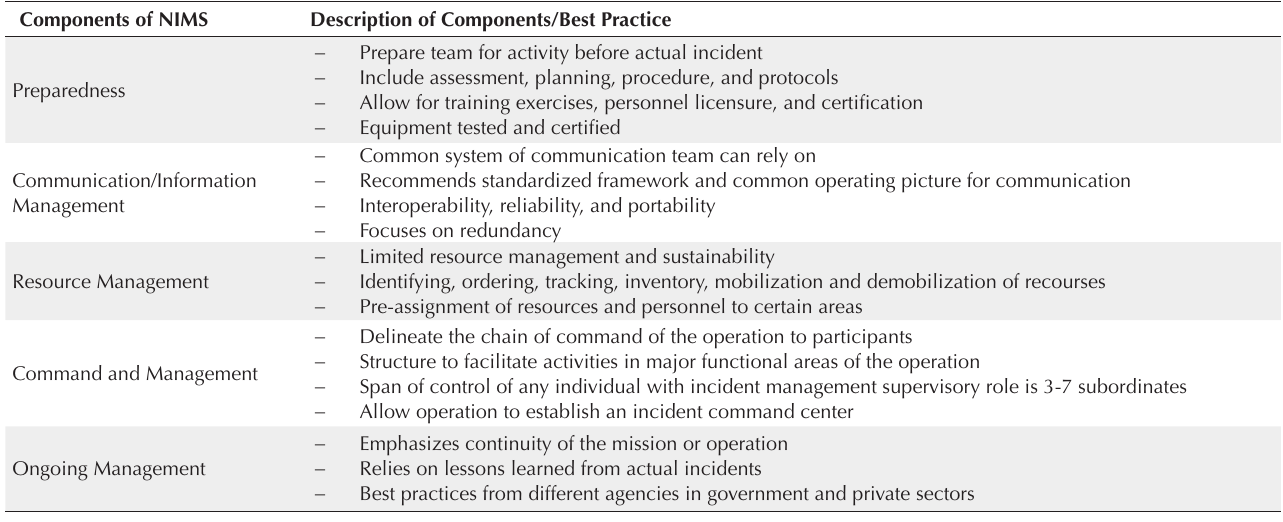
Table 1. Components of NIMS and Description (National Incident Management System, 2008) Components of